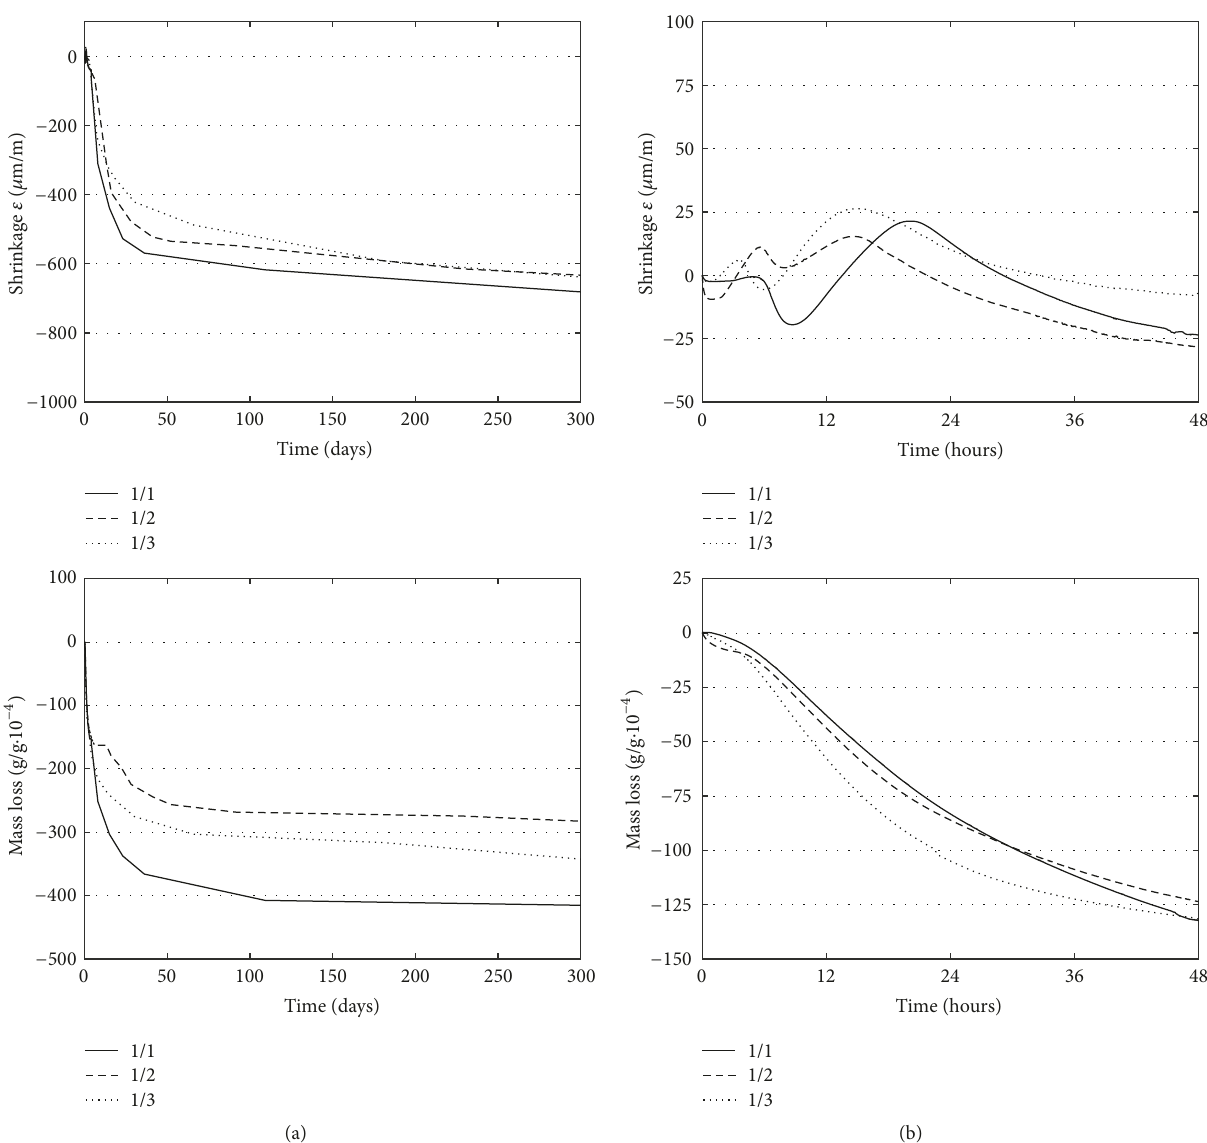
Figure 8: Progress of shrinkage/swelling and mass loss for concretes 1/1, 1/2, and 1/3 ((a): measurement over the whole time of setting and hardening; (b): early age